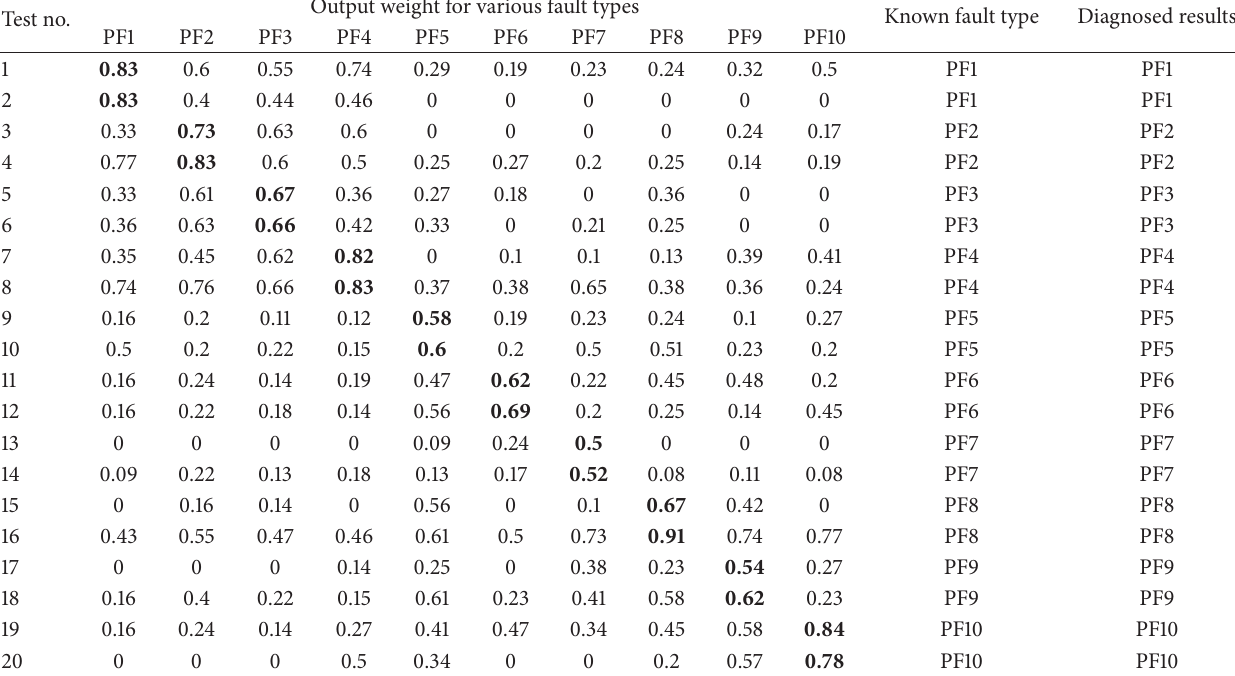
Table 9: Diagnosis results of the test data with additional errors and under 300–1000 W/m 2 irradiation and PV module surface temperatures between 31 and 40 ∘